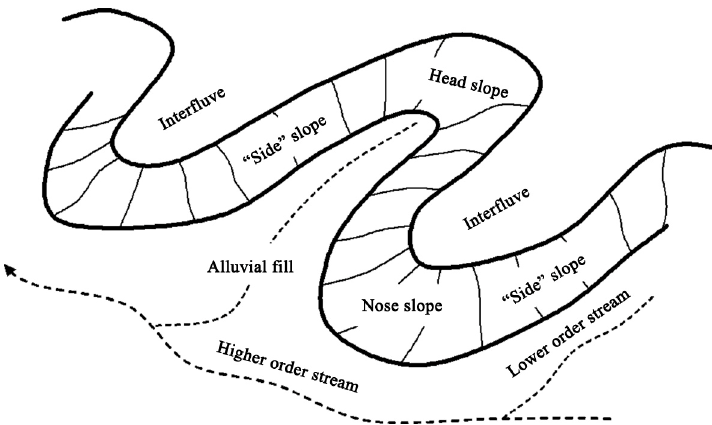
Figure 3. Illustration of terrain positions of hills (Modified from Ruhe [38]).